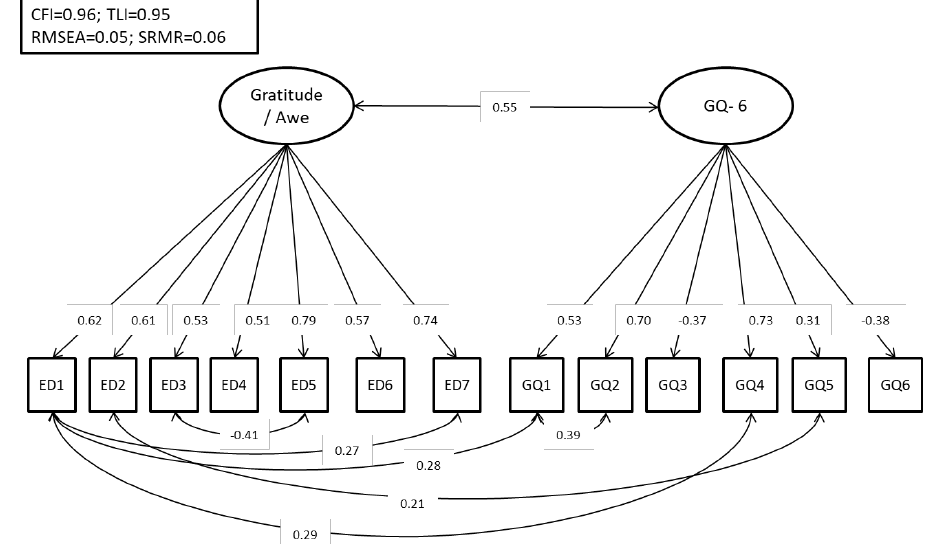
Figure 2. SEM for Gratitude/Awe (GrAw-7) and gratitude disposition (GQ-6). Values on arrows between items (in boxes) and factors (in circles) represent loadings, while items between boxes and circles, respectively, represent correlations.